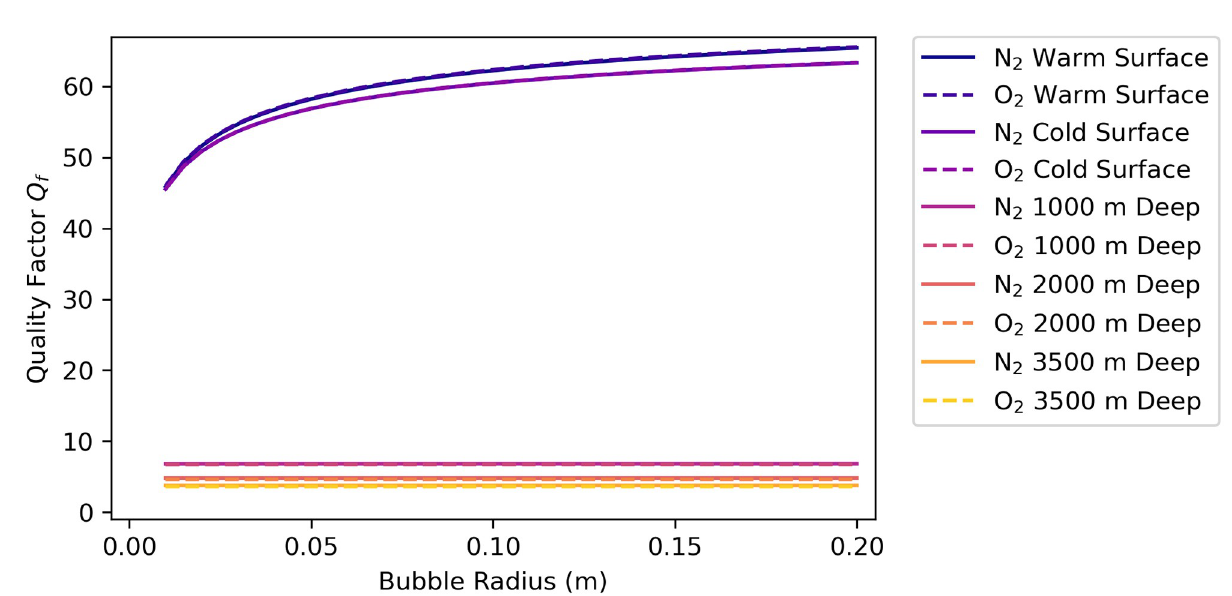
Fig 7. Quality factor Q vs. bubble radius. Values are shown for bubbles at the warm ocean surface and cold ocean surface and at depths of 1000 m, f 2000 m, and 3500 m. The quality factor curves for nitrogen and oxygen bubbles overlap in each of the environments. See section 9 in S3 and S4 Files for the calculations used for this